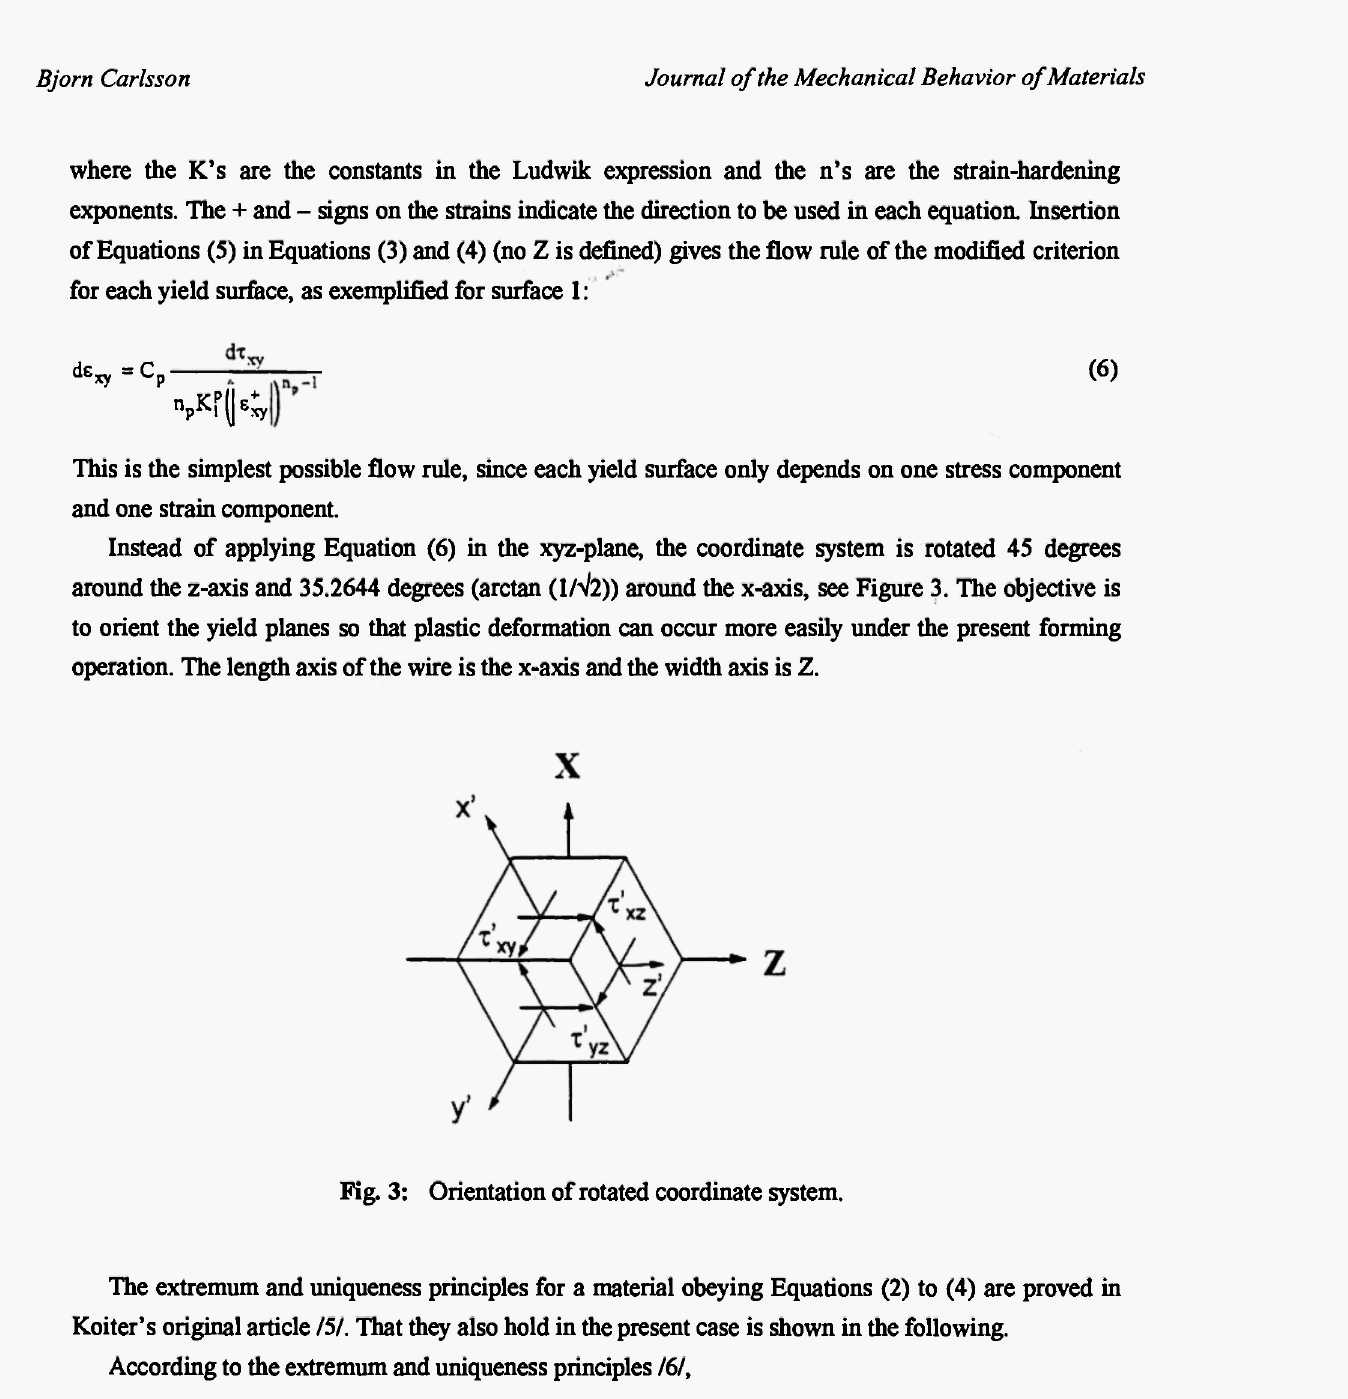
Fig. 3: Orientation of rotated coordinate